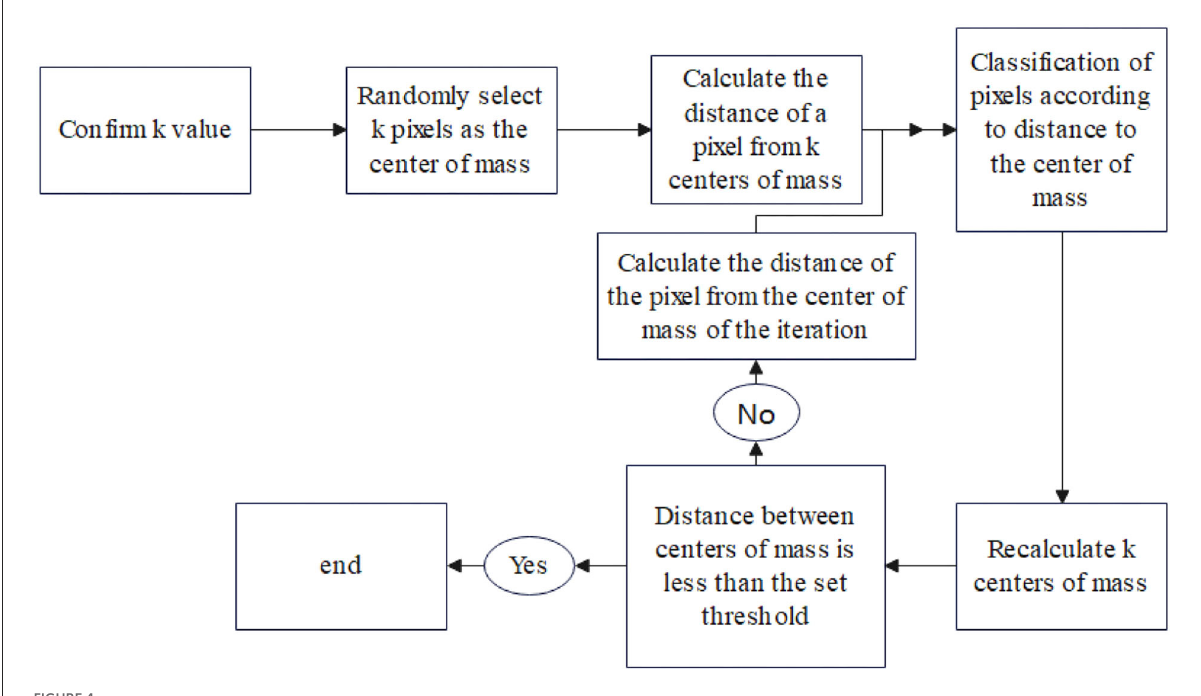
FIGURE4 k- means algorithm clustering block diagram.